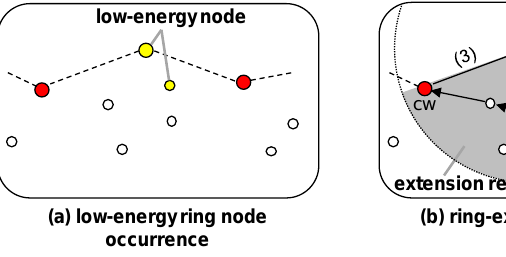
Figure 5. Ring extension of MRR